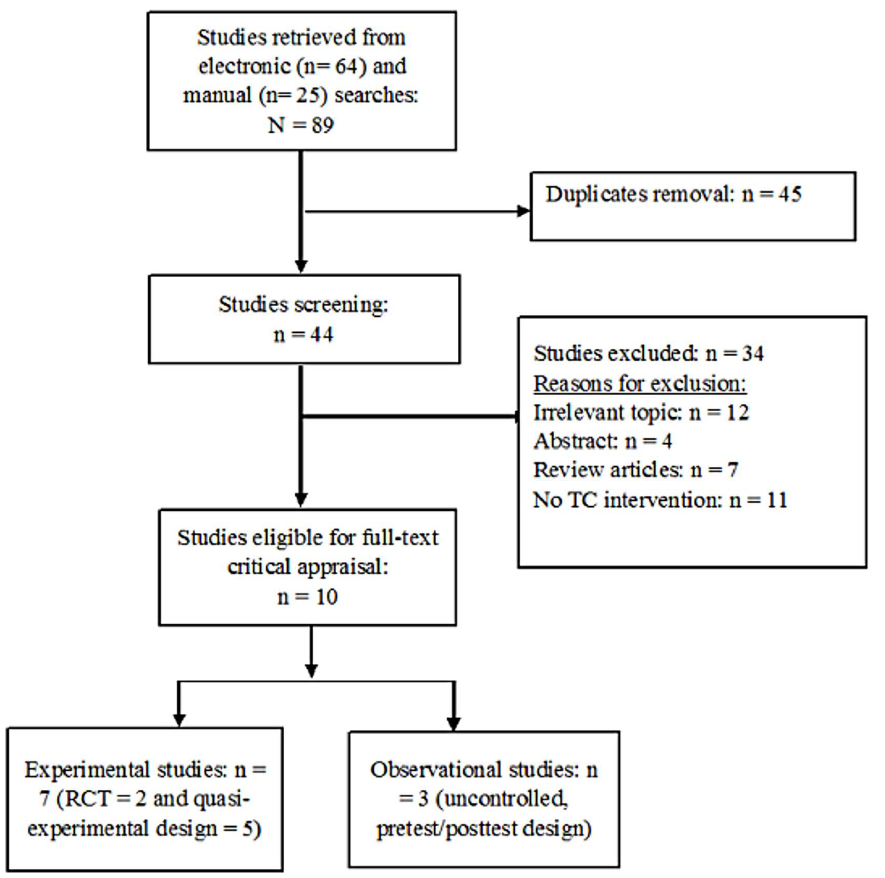
Fig 1. Flow chart showing the study